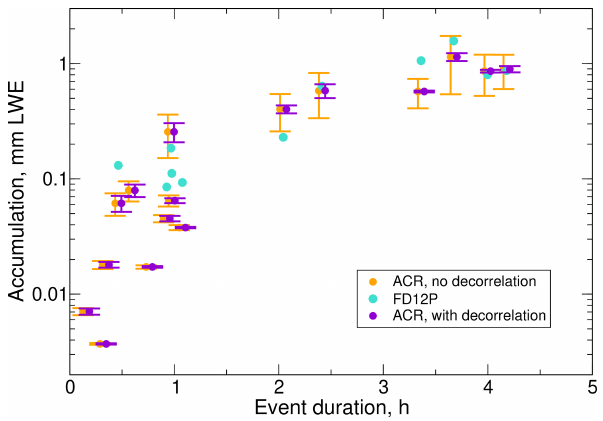
Figure 12. End-of-event accumulations and uncertainties. The P ACR accumulation uncertainties are estimated assuming intra- event errors are perfectly correlated (orange) and decorrelated us- ing a negative exponential model with a decorrelation scale of 0.5h (purple). P FD12P accumulations (blue-green) are shown for com- parison except for those equal to zero, which are omitted. For clar- ity, the P ACR accumulations are plotted at ± 0 . 02h (purple/orange) of their actual